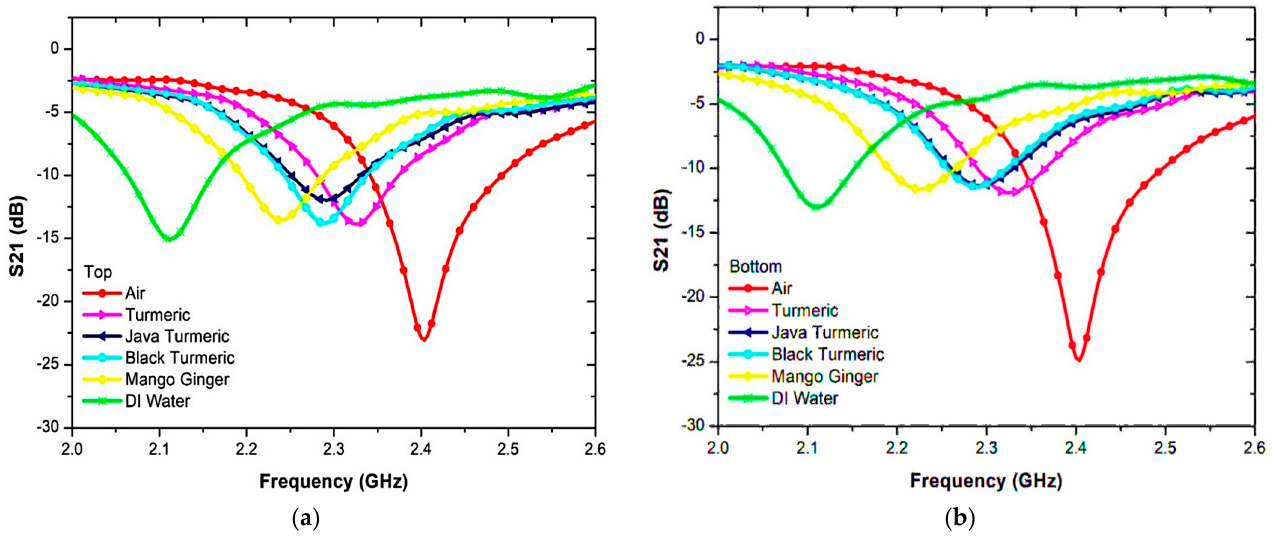
Figure 14. Position of PP tube loaded at the center of Curve-feed CSRR sensor, ( a ) Top and ( b ) bottom.